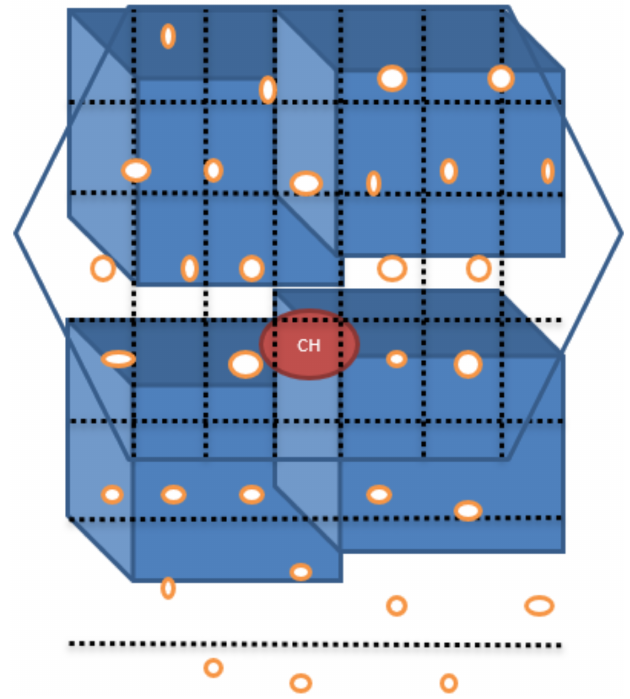
Figure 4. Clustering process at one coverage